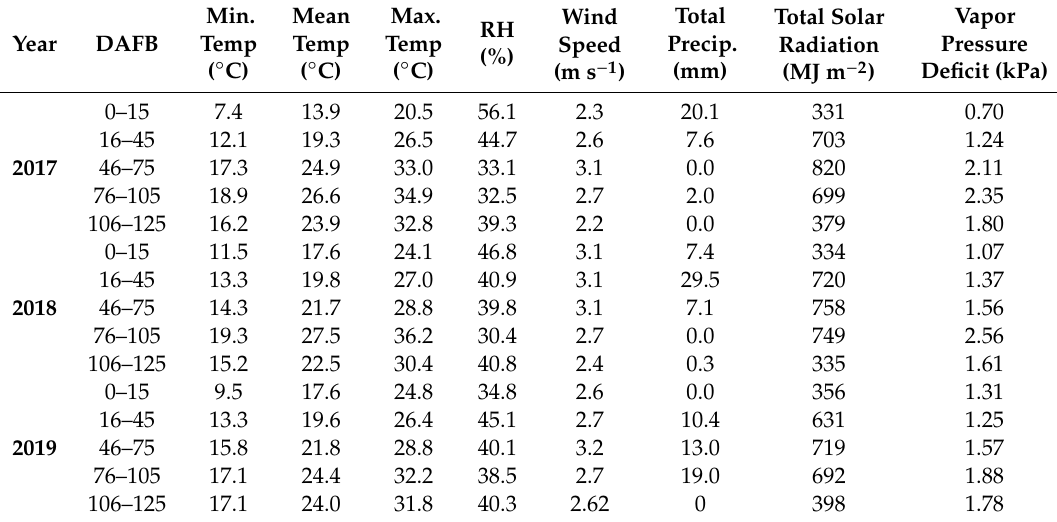
Table 2. Average weather conditions during specific growing days including minimum, average, and maximum temperature, relative humidity (RH), wind speed, total precipitation, total solar radiation, and vapor pressure deficit from full bloom to harvest at Sunrise Research Orchard in Rock Island,